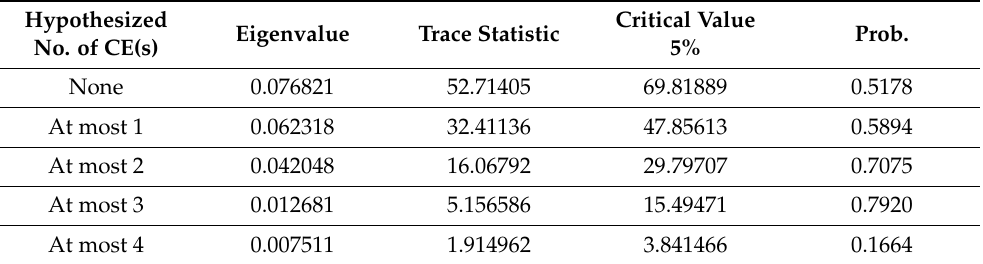
Table 4. Trace statistic—Johansen cointegration method (pre-COVID-19 period). Hypothesized